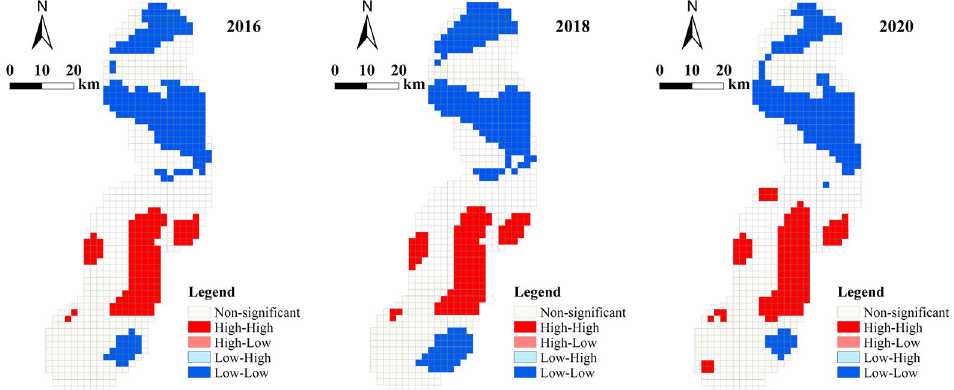
Figure 7. Local spatial autocorrelation diagrams of the ecological risk